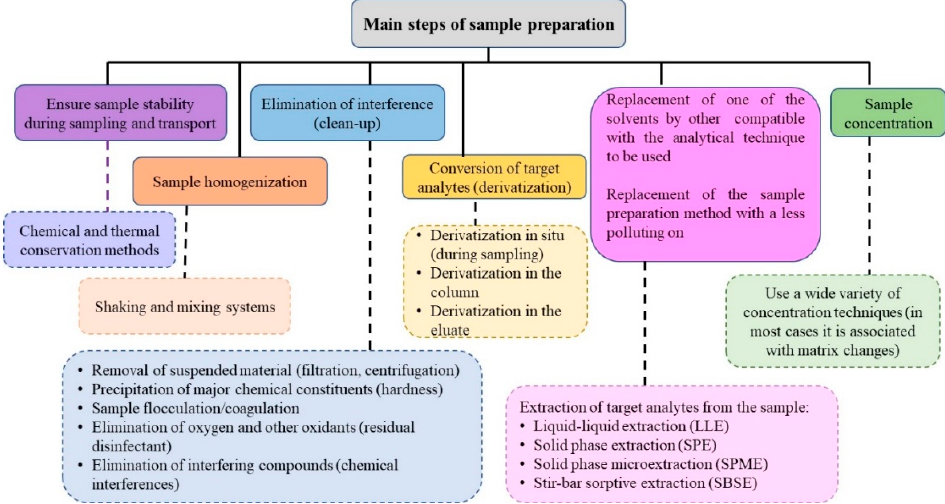
Figure 1. Main steps of sample preparation methods. Legend: Steps (—) and procedures to be implemented ( − − − ) [72].